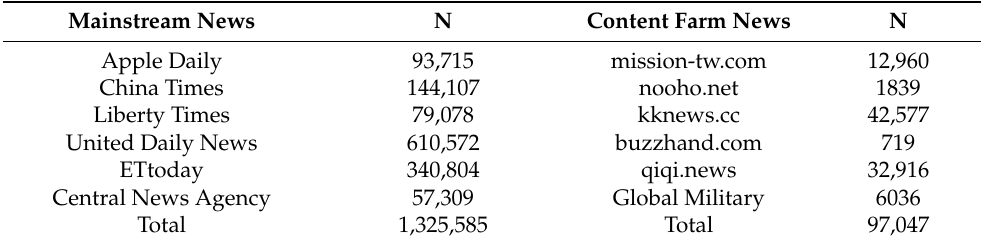
Table 1. News data